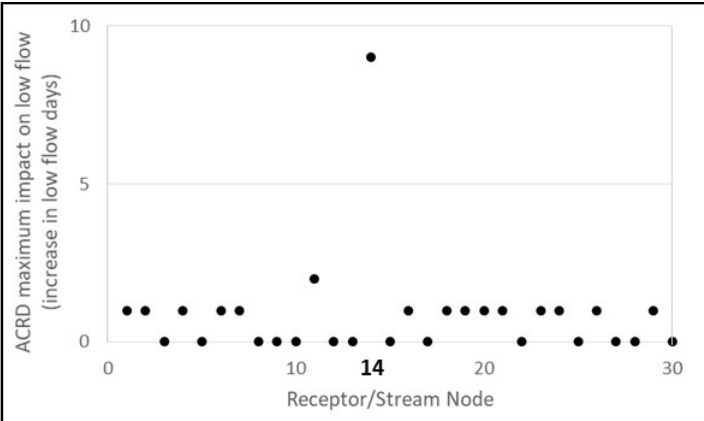
Figure 4. ACRD maximum impact on low flow (presented as the increase in the number of days with runoff less than the fifth percentile value).